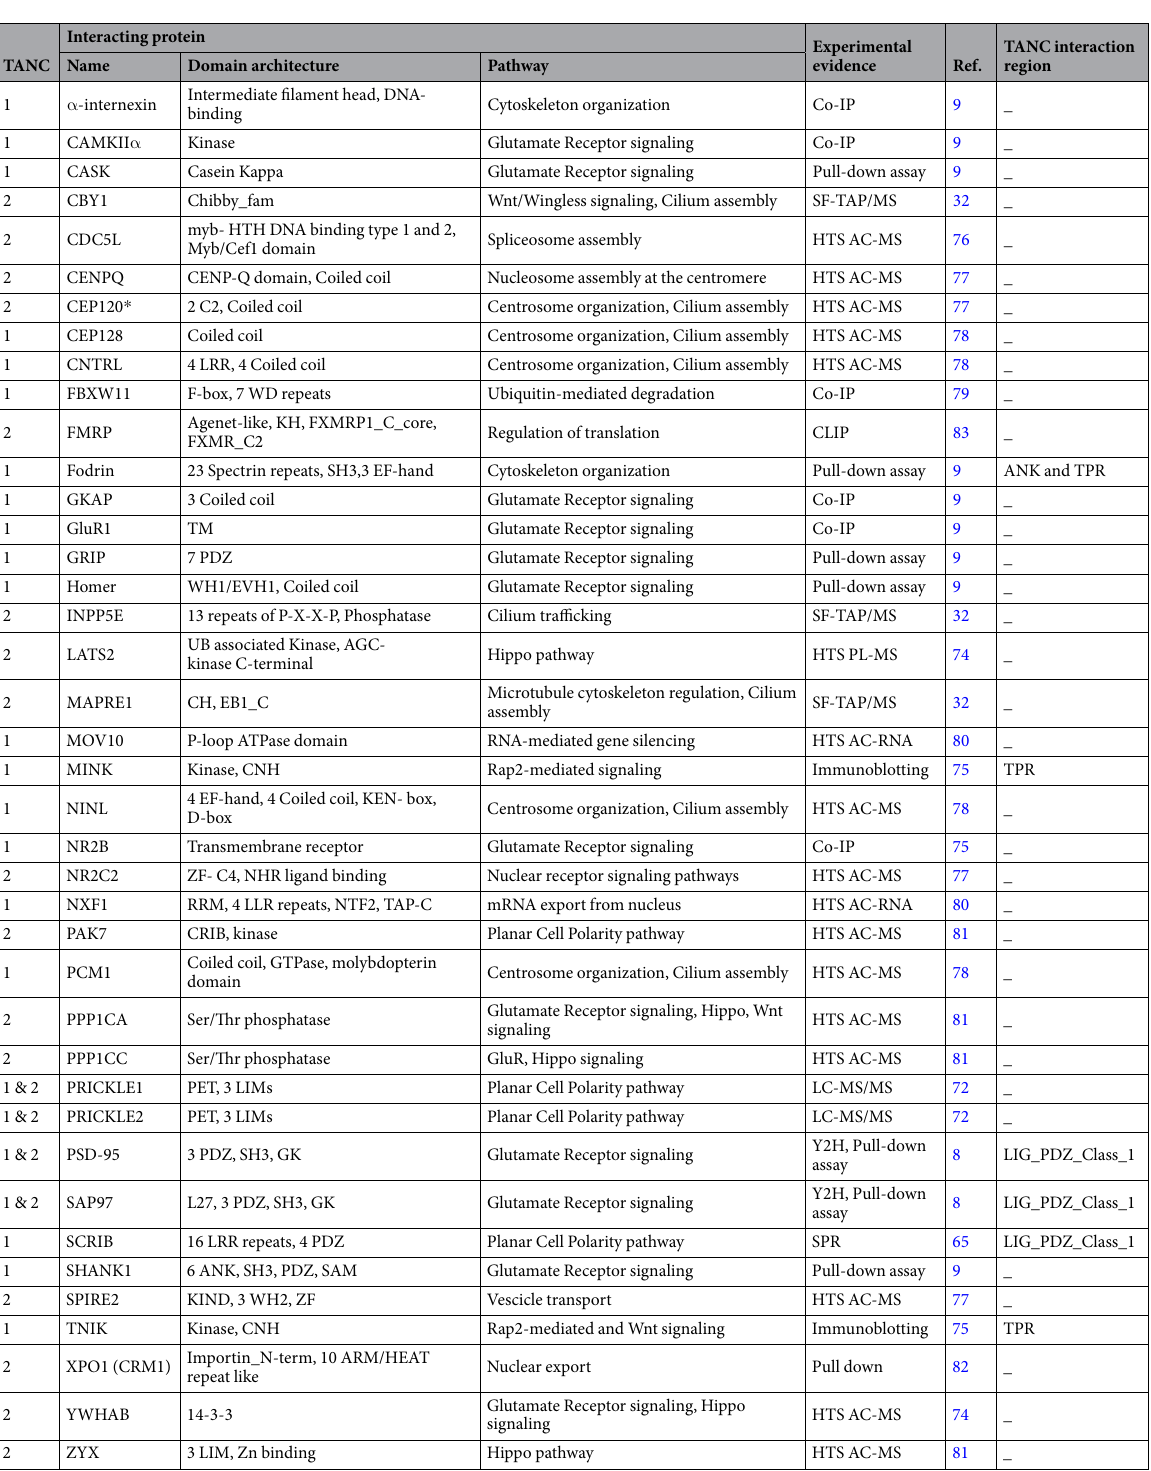
Table 1. List of TANC interactors. For each interactor, the interacting TANC protein, the detection method and the binding region (experimentally validated) are here listed. Y2H: Yeast two hybrid; Co-IP: Co- immunoprecipitation; SPR: Surface plasmon resonance; HTS: High-Throughput System; AC: Affinity Capture; PL: Proximity Label; MS: Mass spectrometry; CLIP: Cross-Linking ImmunoPrecipitation; SF-TAP/MS: systematic tandem affinity purifications coupled to mass spectrometry. SLiMs are named according to the ELM